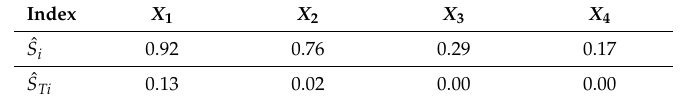
Figure 10. First order and total effect indices for ( a ) the Young’s modulus and ( b ) the yield stress using Kriging regression. Table 4. First order and total effect sensitivity indices for the Young’s modulus using Kriging regression.